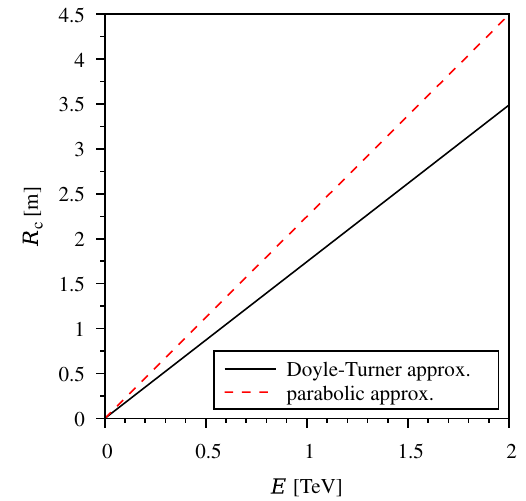
Fig. 2 The dependence of the critical radius of curvature of the crystal on particle energy in parabolic and Doyle–Turner approximation of planar potential